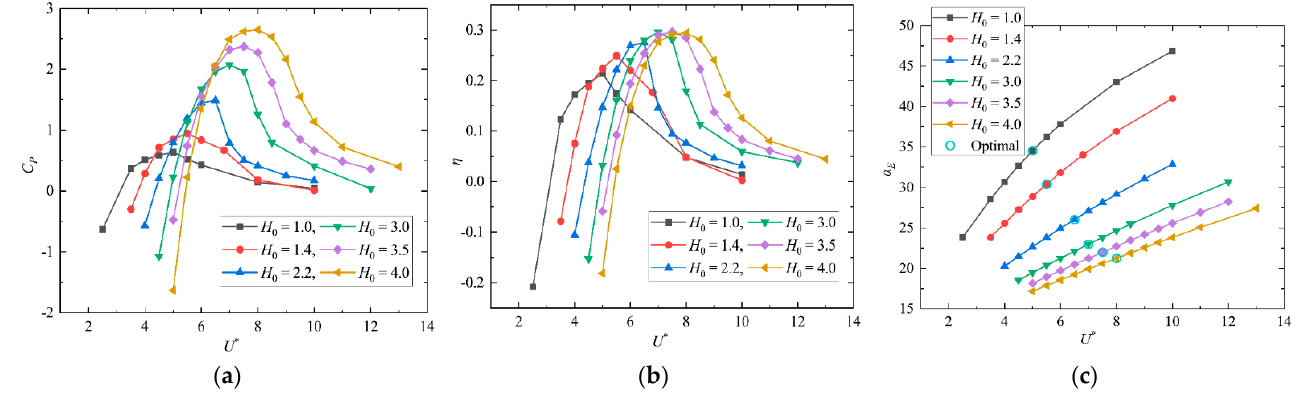
Figure 7. Variations of the power coefficient, efficiency, and α e with reduced velocity and plunging amplitude. ( a ) Power coefficient. ( b ) Energy extraction efficiency. ( c ) Effective AOA.